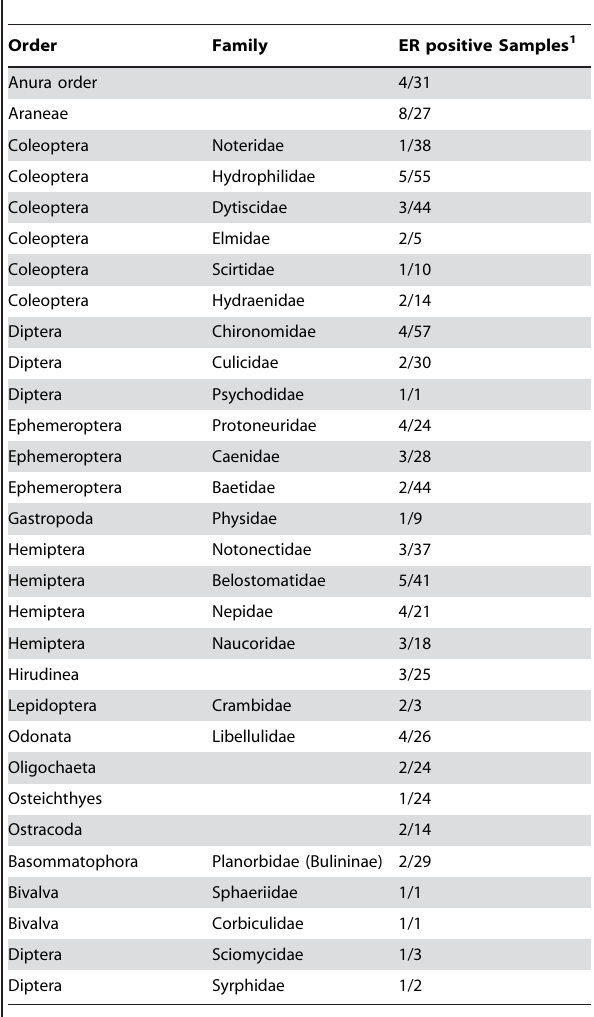
Table 2. Presumptive identification of M. ulcerans in aquatic vertebrate and invertebrate samples in Ghana